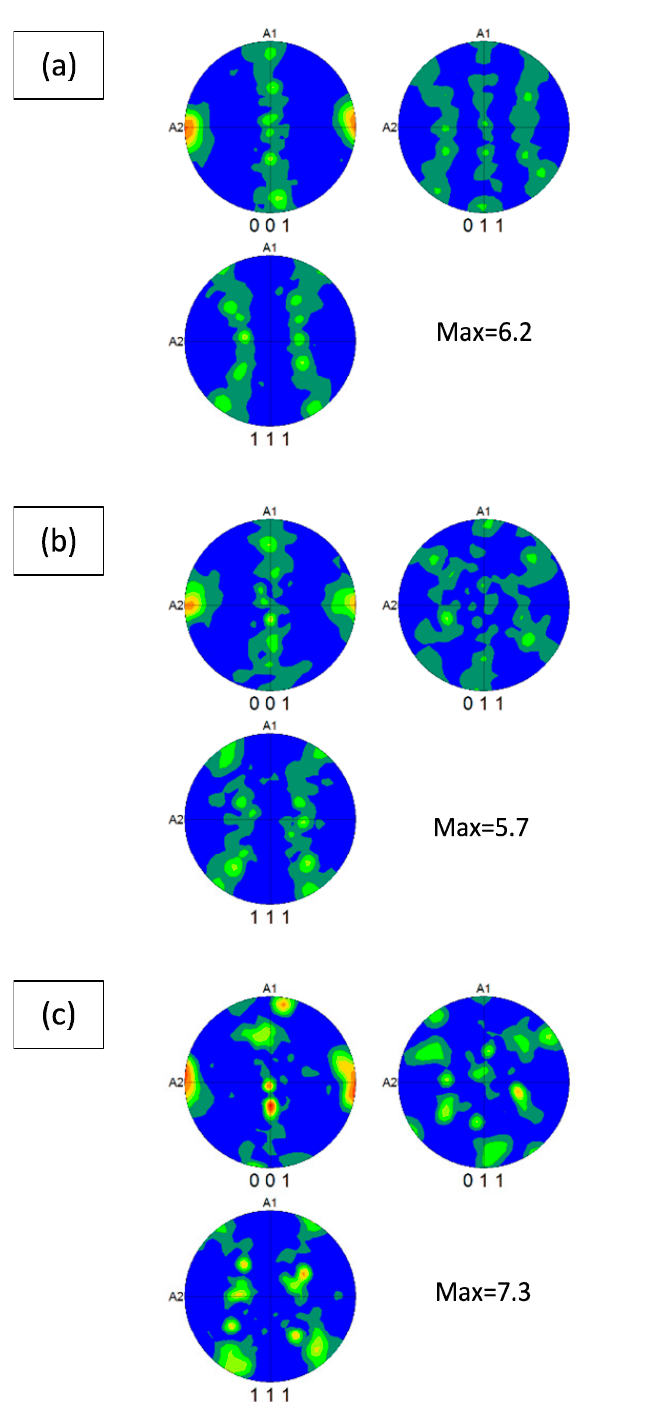
Figure 11. Pole figures of the electrodeposited Ni on copper ( a ) without and with the addition of ( b ) 5 g / L of TiO 2 , ( c ) 10 g / L of TiO 2 TiO 2 , ( b ) 5 g/L of TiO 2 , ( c ) 10 g/L of TiO 2 .